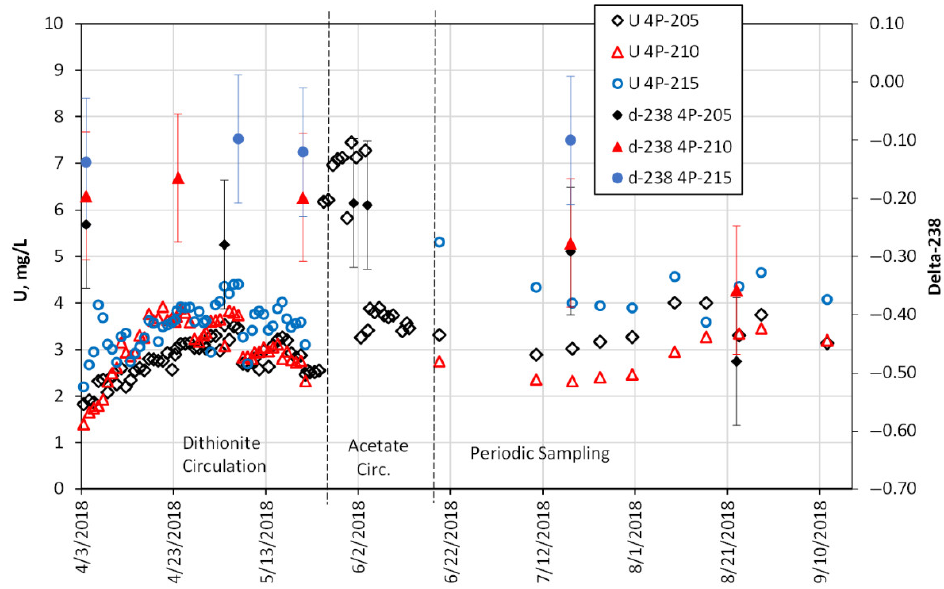
Figure 6. U concentrations and δ 238 U in wells 4P-205, -210, and -215 during the amendments test. Error bars for δ 238 U represent the analytical uncertainty ( ± 2 standard deviations) of the isotope measurements.